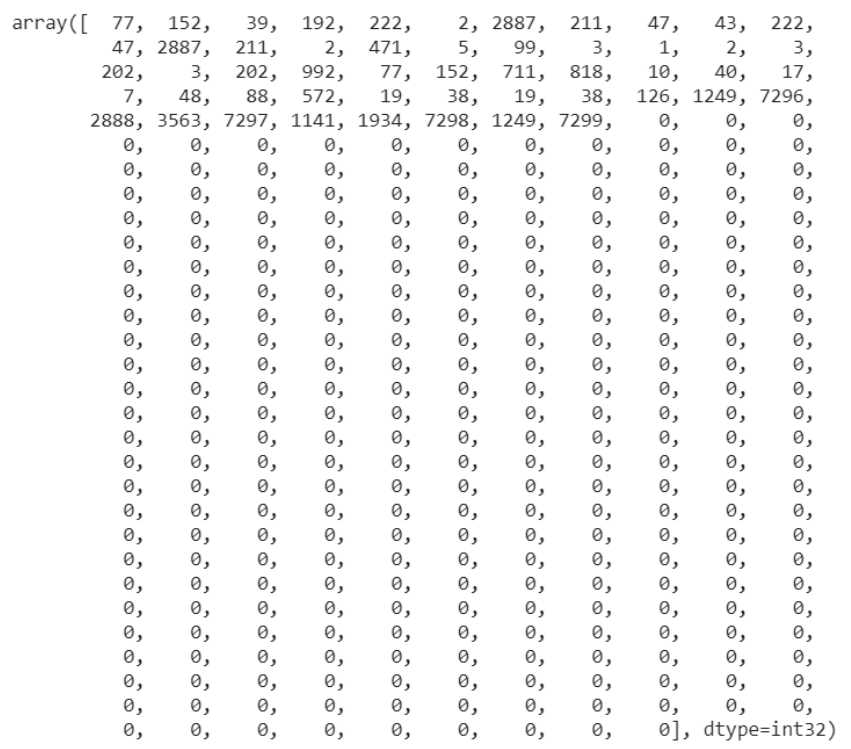
Figure B-19 an example of input features of deep learning models